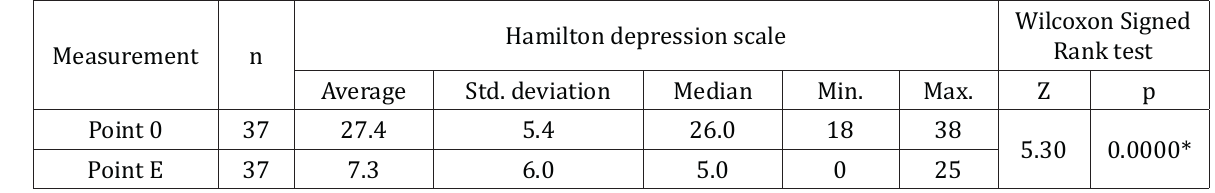
0) and end time (Point E). Table 11. Descriptive statistics – Severity of depression amongst the tested patients, according to the HDRS, at two points in time and the results of a Wilcoxon Signed Rank